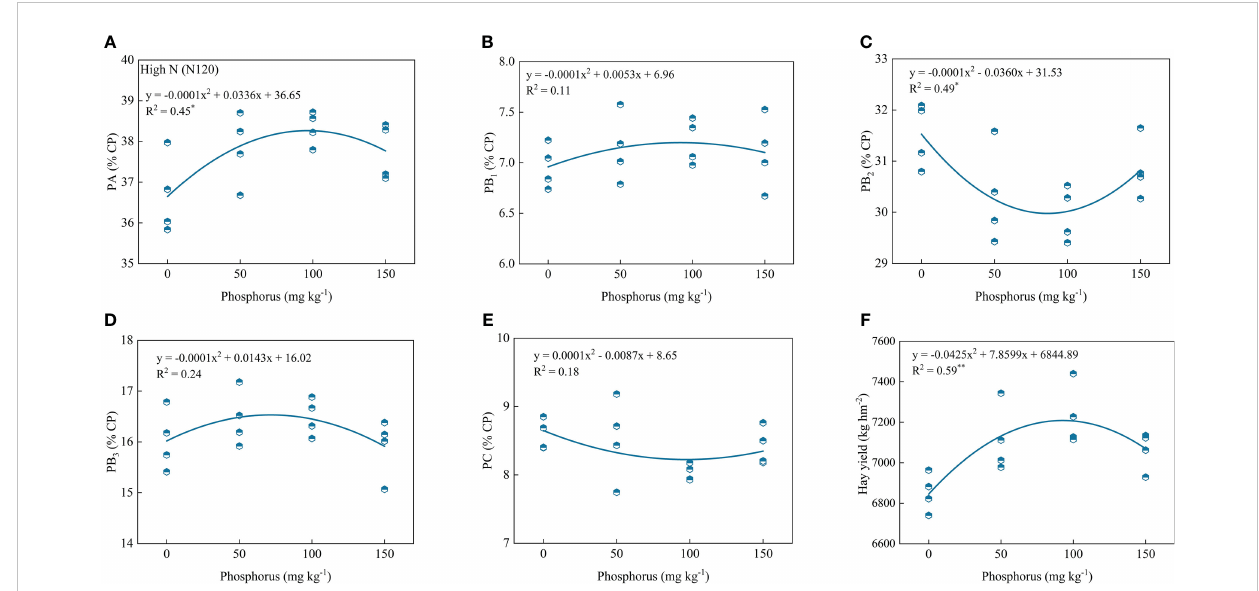
FIGURE 6 Relationship of PA (A) , PB 1 (B) , PB 2 (C) , PB 3 (D) , PC (E) and forage yield (F) with phosphorus treatments under high nitrogen condition. * and ** indicates the signi fi cant level at p ≤ 0.05 and p ≤ 0.01, respectively. The X and Y axes were adjusted to minimize the graph ’ s blank areas and highlight the